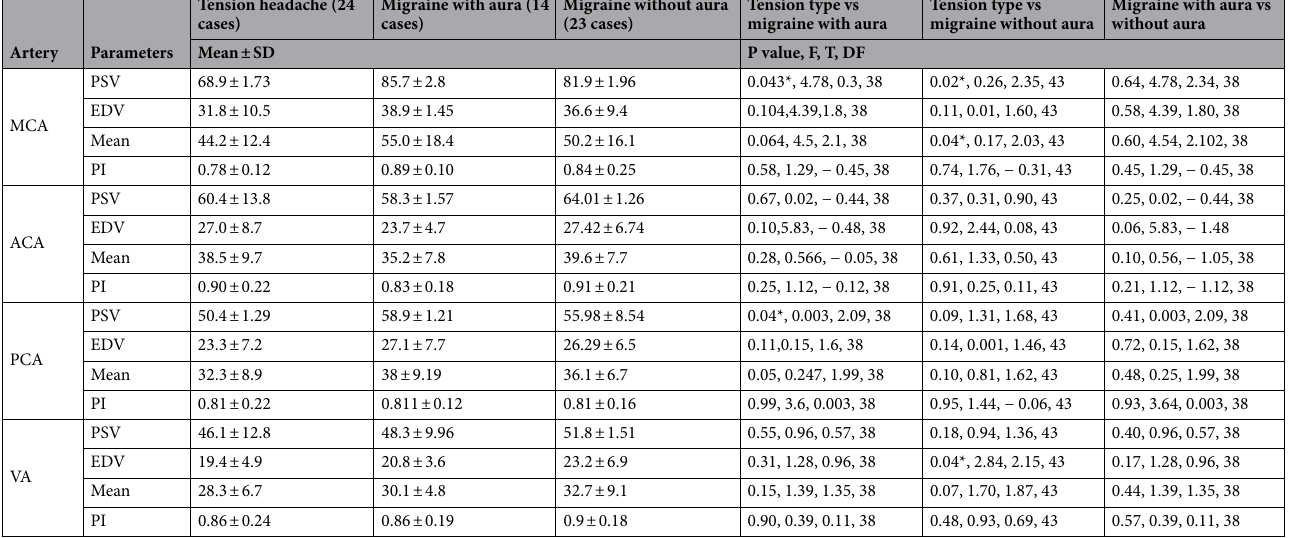
Table 4. Differences in the Resting duplex parameters of anterior and posterior cerebral circulations between different types of headaches (tension-type headache, migraine with aura and migraine without aura). MCA middle cerebral artery, ACA anterior cerebral artery, PCA posterior cerebral artery, VB vertebral artery, PSV Peak Systolic velocity, EDV End Diastolic Velocity, PI pulsatility Index, mean mean flow velocity, P value is significant < 0.05, *the significant between each group with